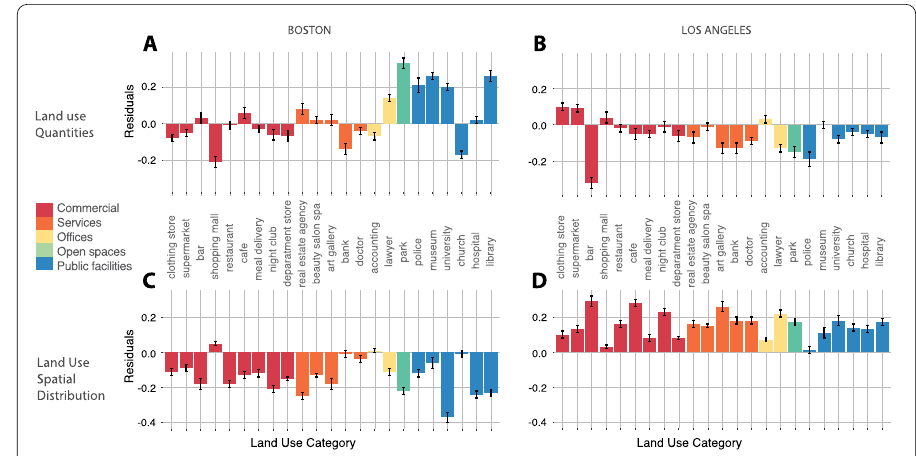
Figure 4 Urbansignatures . The deviations from the regression line in double logarithmic scale are visualized as bars with the height of the bar being the value of the residual. Each color represents a different group of amenity types. We selected 23 representative categories from the amenity types that show a good fit with the population. ( A ), ( B ) Deviations from the expected quantity of amenities. Boston exceeds the expected quantities of most public facilities (e.g., libraries and museums) and open spaces while Los Angeles shows negative deviations in most amenity types. ( C ), ( D ) Deviations from the expected spatial distribution. Most amenities in Boston are more evenly distributed than expected, whereas in Los Angeles, most amenities are scattered around the